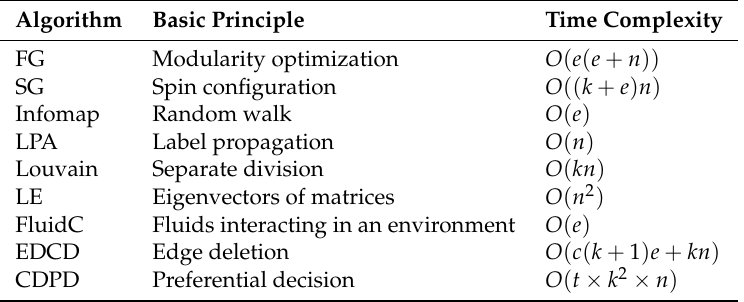
Table 2. The basic principle and time complexity of algorithms used for comparison. Algorithm